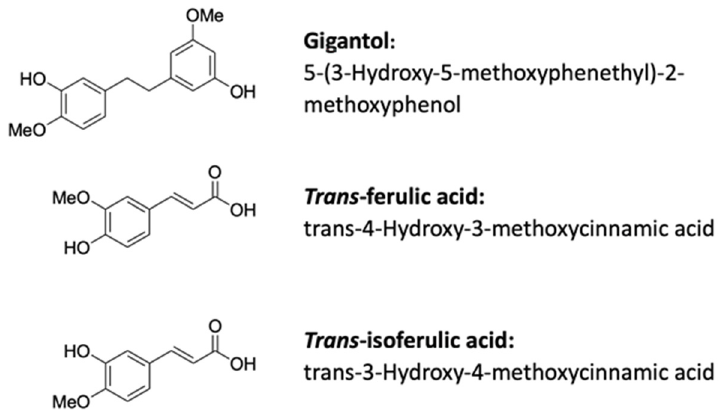
Figure 1. Schematic representation of gigantol (GOL), trans -ferulic acid (FA) and trans -isoferulic acid (IFA).